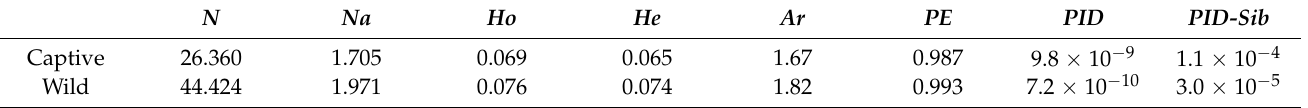
Table 1. Genetic diversity indices of two populations of Tsushima leopard